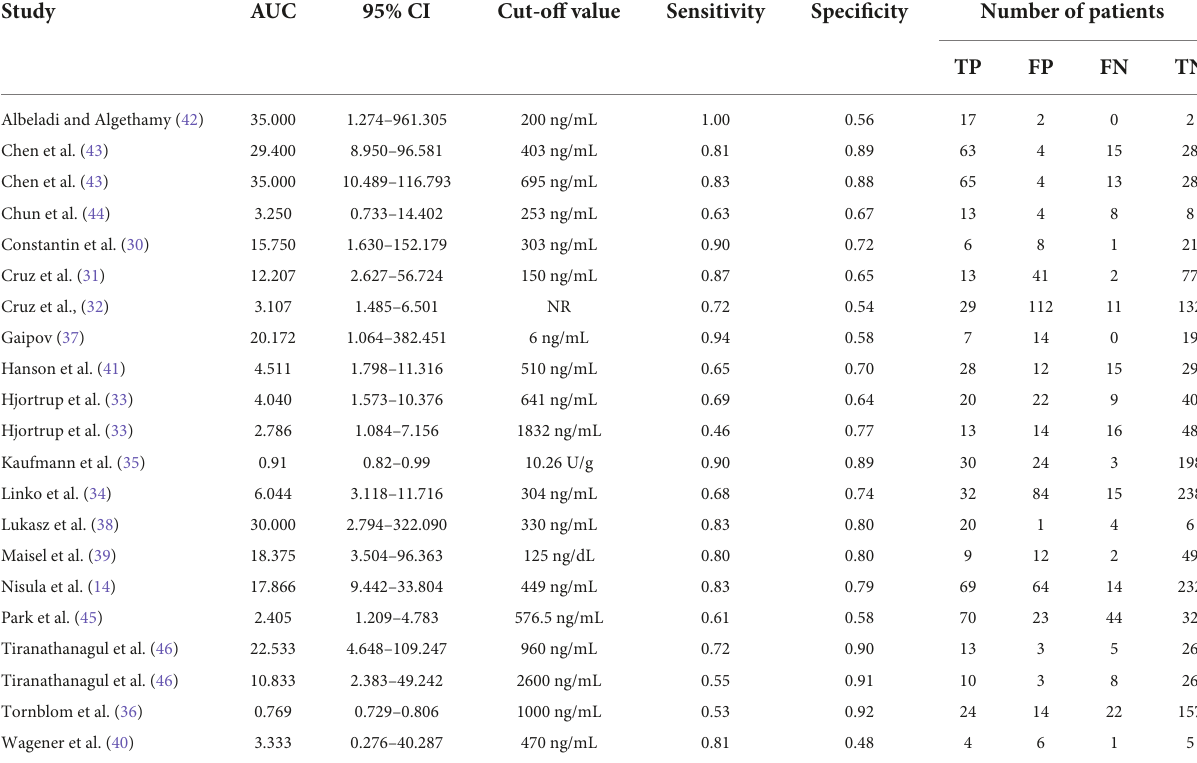
TABLE 2 Predictive value of NGAL on AKI requiring RRT in individual